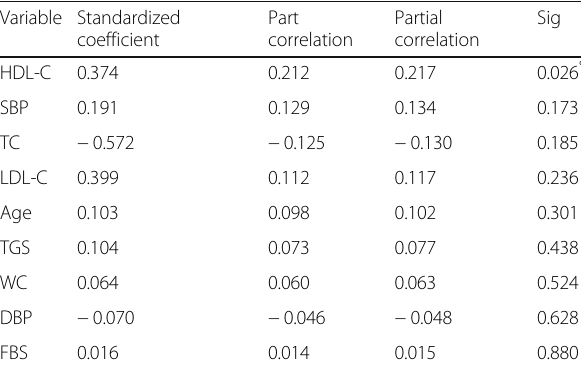
Table 6 Multiple linear regression analysis predicting NIHSS in all studied patients Variable Standardized coefficient